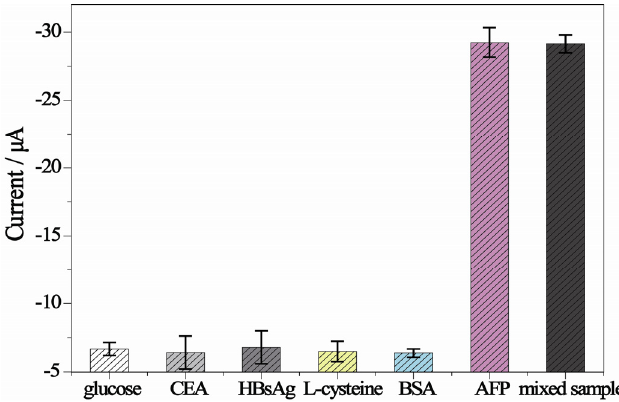
Figure 5. Selectivity of the electrochemical ELISA system to AFP (5 ng/mL) by comparing it to the interfering protein: glucose (50 ng/mL), carcinoembryonic antigen (CEA, 50 ng/mL), hepatitis B virus surface antigen (HBsAg, 50 ng/mL), L -cysteine (50 ng/mL), bovine serum albumin (BSA, 50 ng/mL), and the mixed sample containing 5 ng/mL AFP, 50 ng/mL